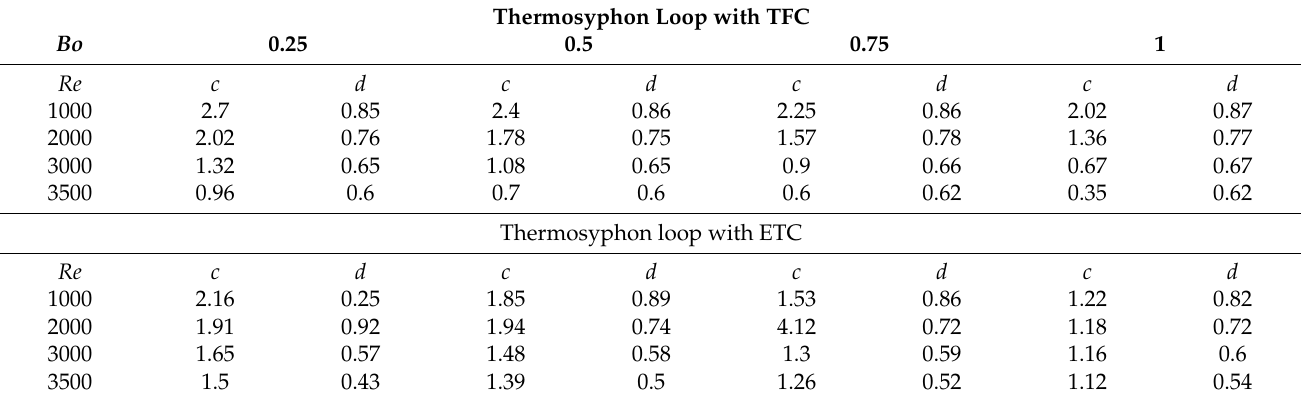
Table 6. c , and d coefficients at each Bo and Re tested for the loops with TFC and ETC. Thermosyphon Loop with TFC